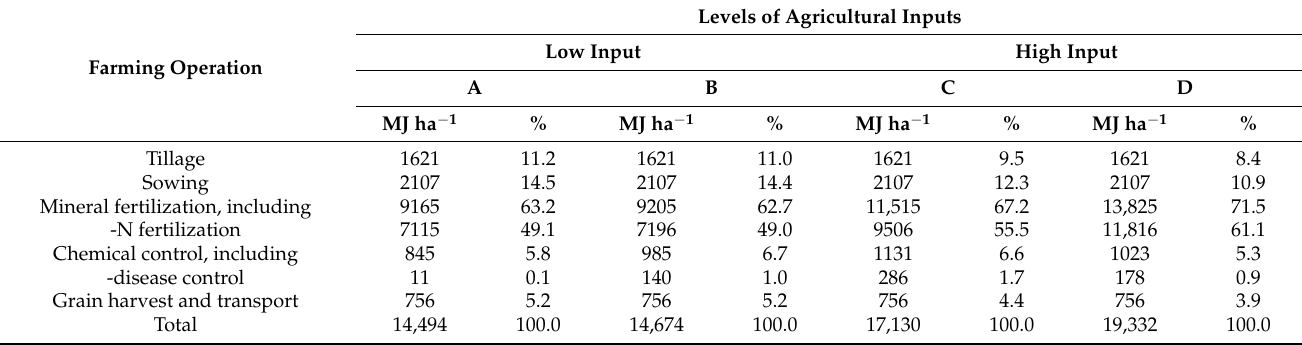
Table 4. Structure of energy inputs in the production of a semi-dwarf genotype of winter triticale per farming operation (2008–2011).